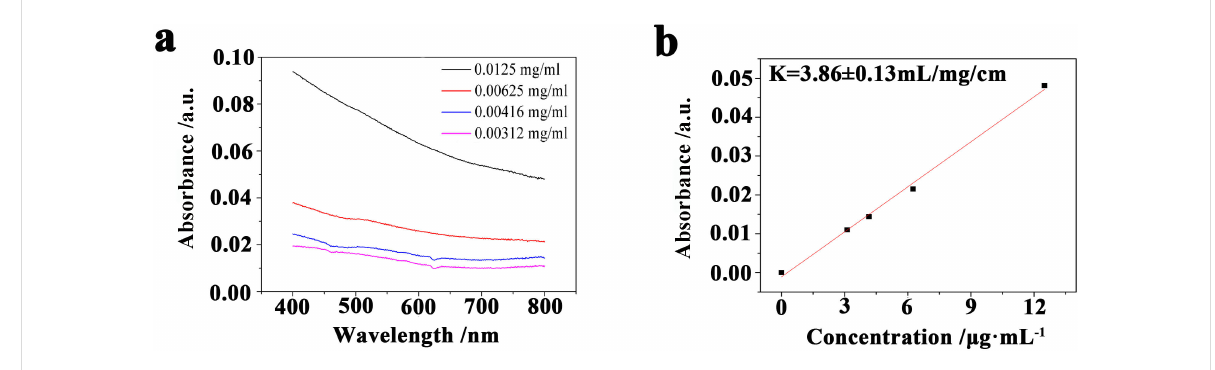
Figure 2: Absorbance of predetermined KP 15 dispersions exfoliated in butyrolactone. (a) Absorbance of different concentrations of predetermined KP